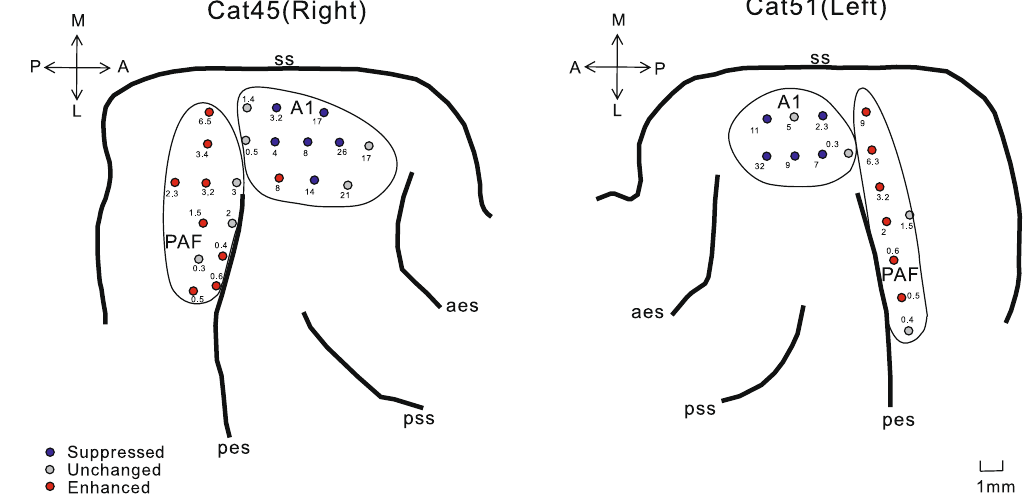
Figure 1. Reconstruction of the locations of recorded units in the AC of two representative cats. Different symbols mark the location of different groups of units. A1: primary auditory cortex; aes: anterior ectosylvian sulcus; PAF: post auditory field; pes: post ectosylvian sulcus; pss: pseudosylvian sulcus; ss: